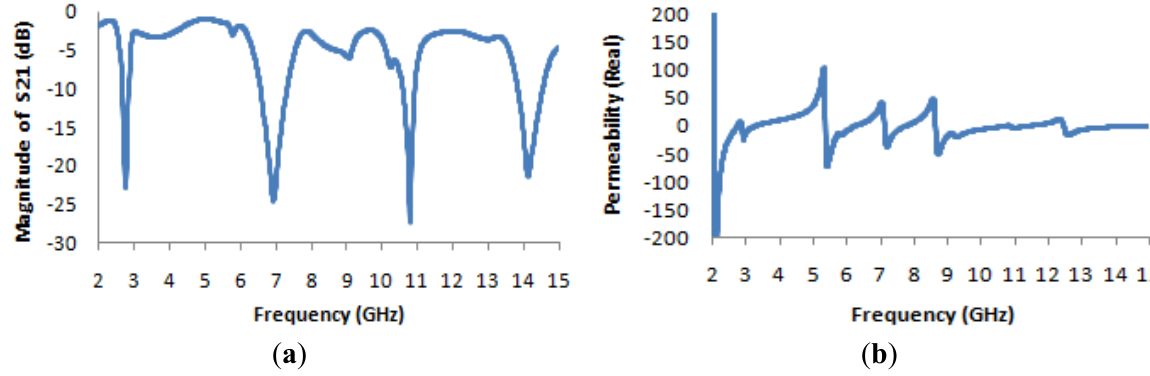
) in units of dB for 21